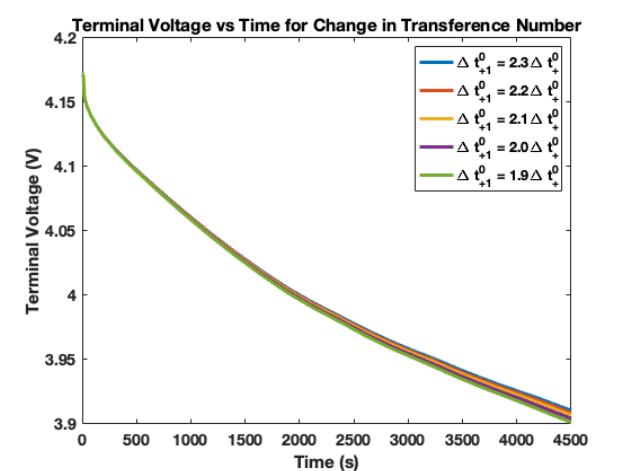
Figure 8. Terminal voltage vs. time for change in transference number from 2.3 to 1.9.